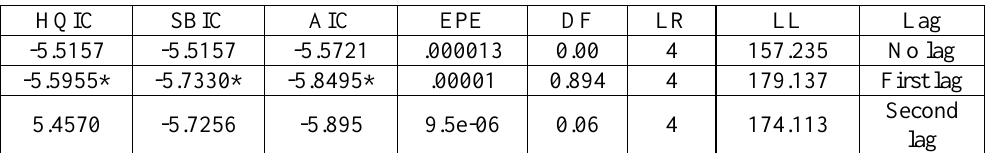
Table 3. Determination of Optimal